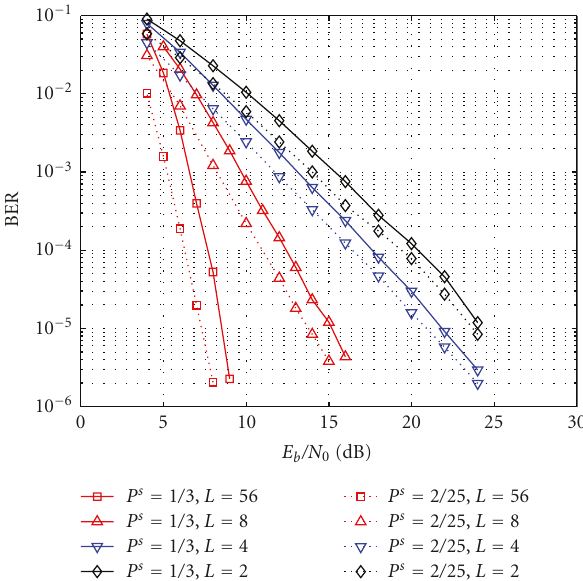
Figure 13: Performance comparison between the two power allocation schemes without source-destination path.